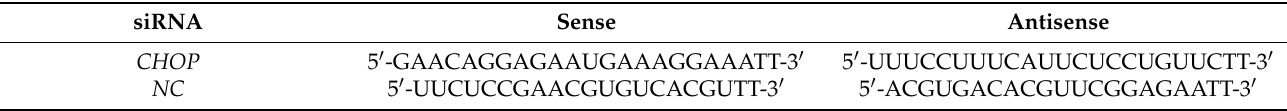
Table 1. siRNA primer